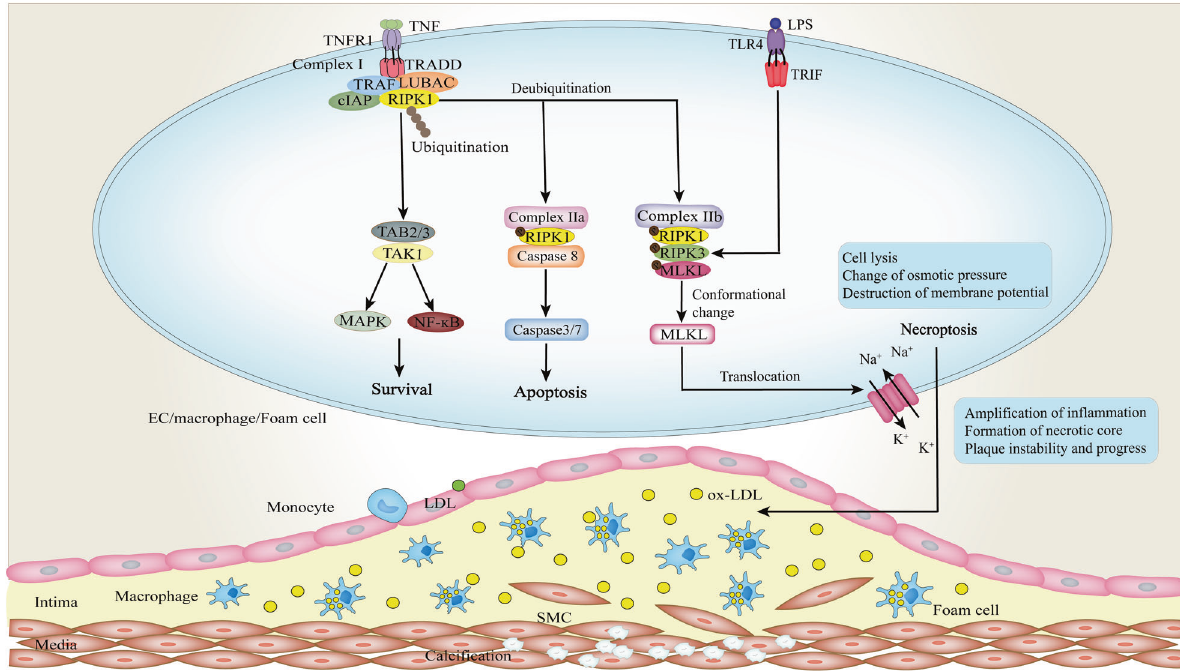
complex I. The deubiquitination of receptor-interacting protein kinases 1(RIPK1) results in the formation of complex IIb, activating the necroptotic signaling cascade. Here, the autophosphorylation of RIPK1 facilitates the phosphorylation and activation of RIPK3, which in turn mediates the phosphorylation and conformational changes of mixed-line kinase domain like (MLKL), eventually causing plasma membrane rupture. In early atherosclerotic diseases, high levels of RIPK1 drive NF- κ B-dependent in fl ammation and the activation of ECs. Activated ECs secrete more adhesion molecules to attract and recruit monocytes and other in fl ammatory cells. Next, ox-LDL induces RIPK3 expression in macrophages and foam cells, promoting cellular necroptosis and the forming of necrotic lipid pool. Ultimately, this leads to plaque instability and rupture, as well as a variety of cardiovascular